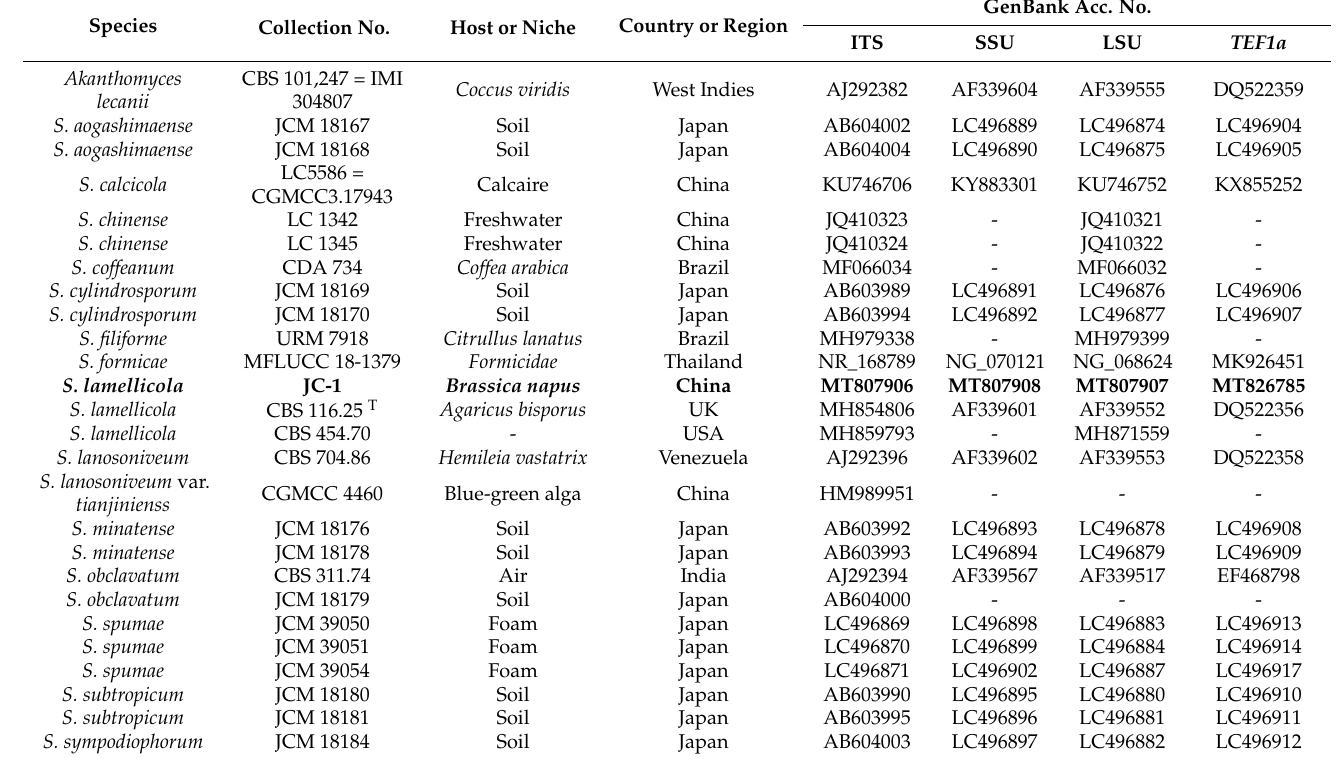
Table 1. Strains and the selected genes used in the phylogenetic